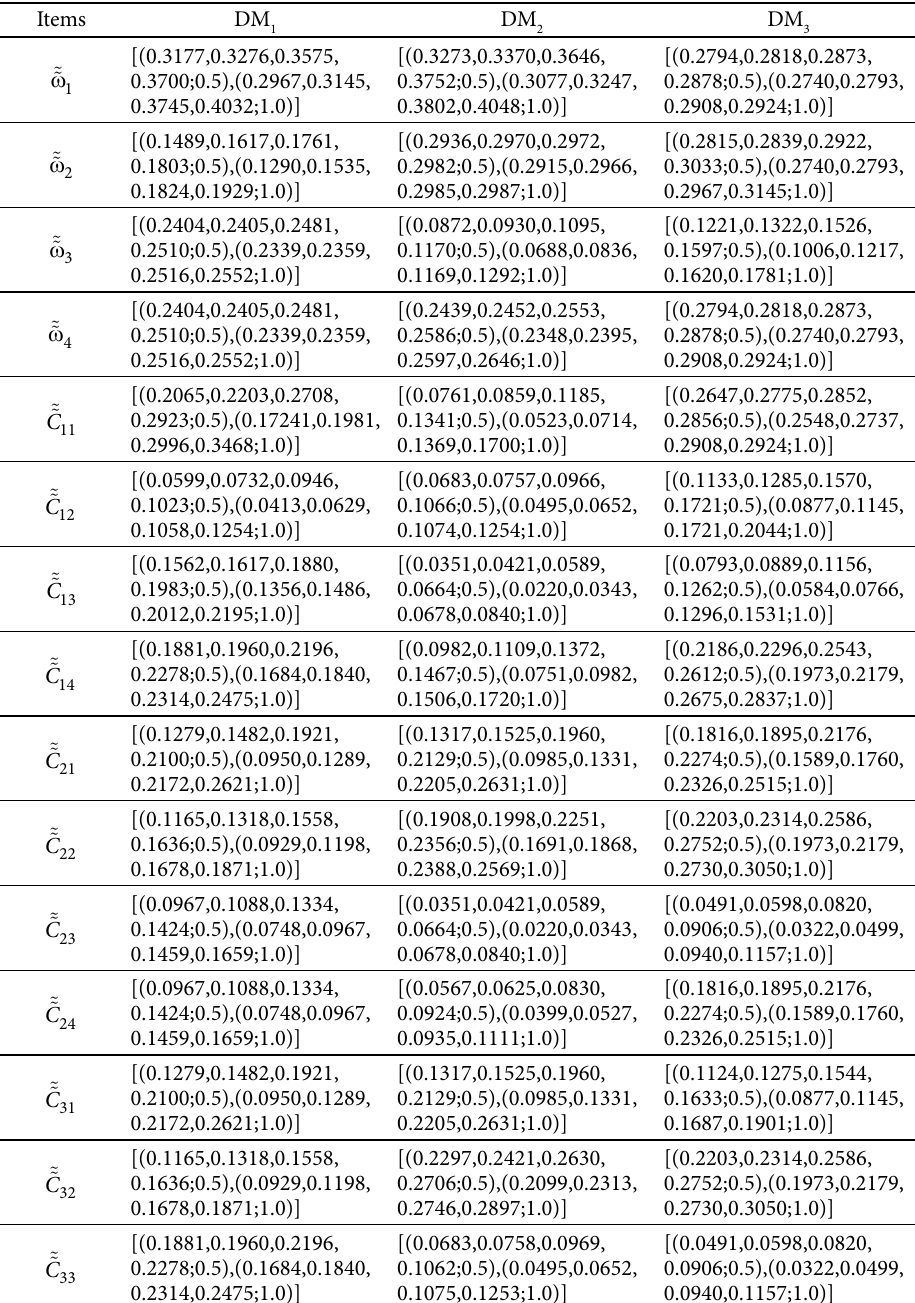
Table A1. Results summary of each decision maker’s